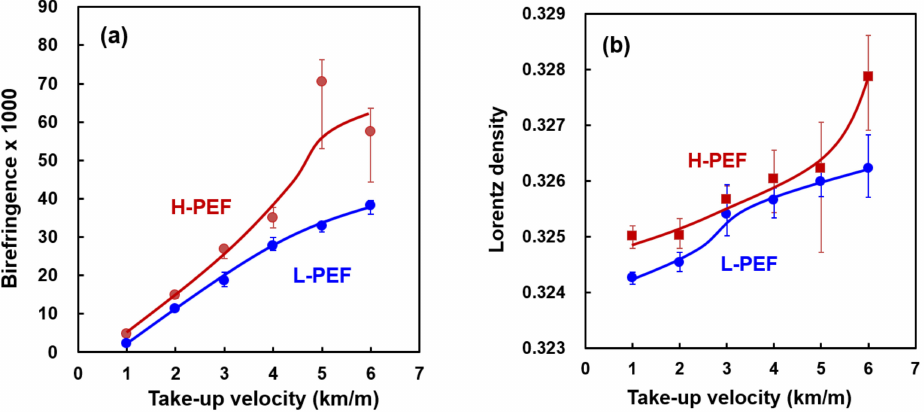
Figure 4. Variations of ( a ) birefringence and ( b ) Lorentz density with take-up velocity for high-speed spun L-PEF and H-PEF fibers.